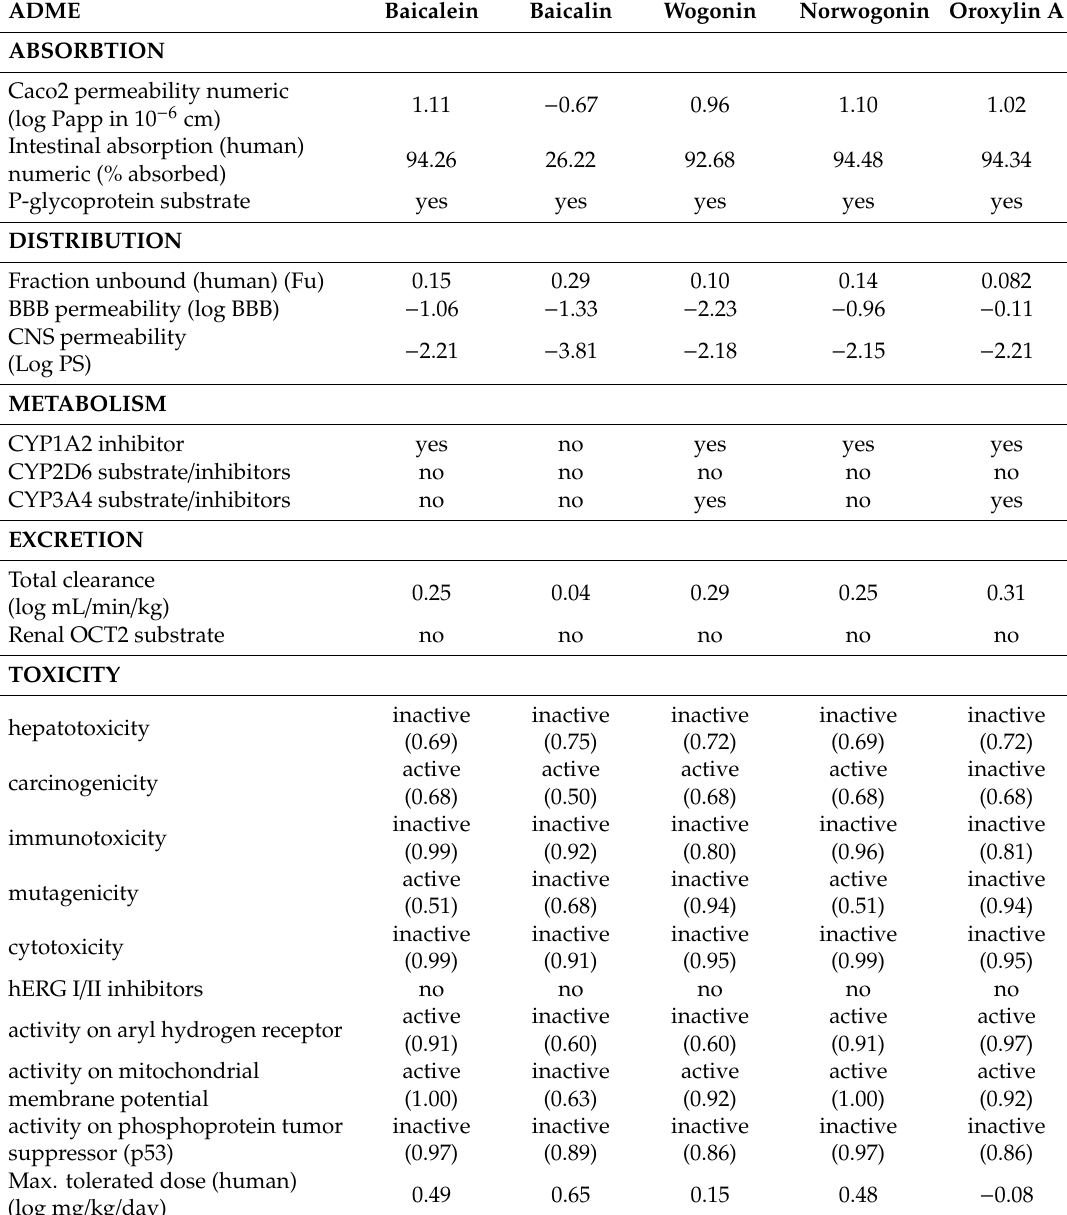
Table 4. Predicted ADME-Tox features of baicalein, baicalin, wogonin, norwogonin, and oroxylin A. Their probability of exhibiting toxicity features is mentioned in